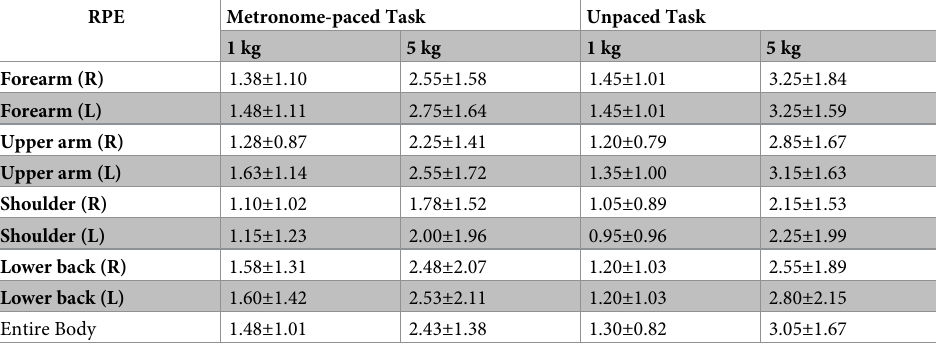
Table 5. The mean and standard deviation of RPE for the Malaysian male subjects during the metronome-paced and unpaced task sessions.